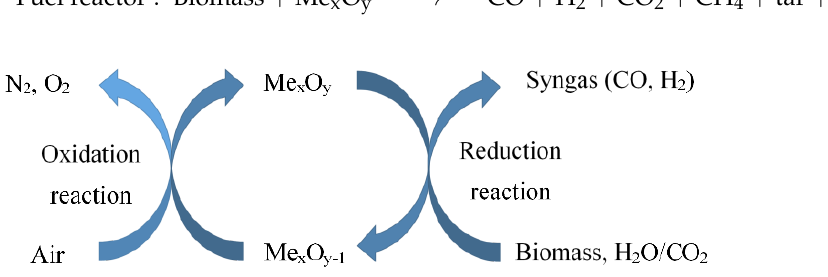
Figure 2. General scheme of biomass chemical looping gasification process .